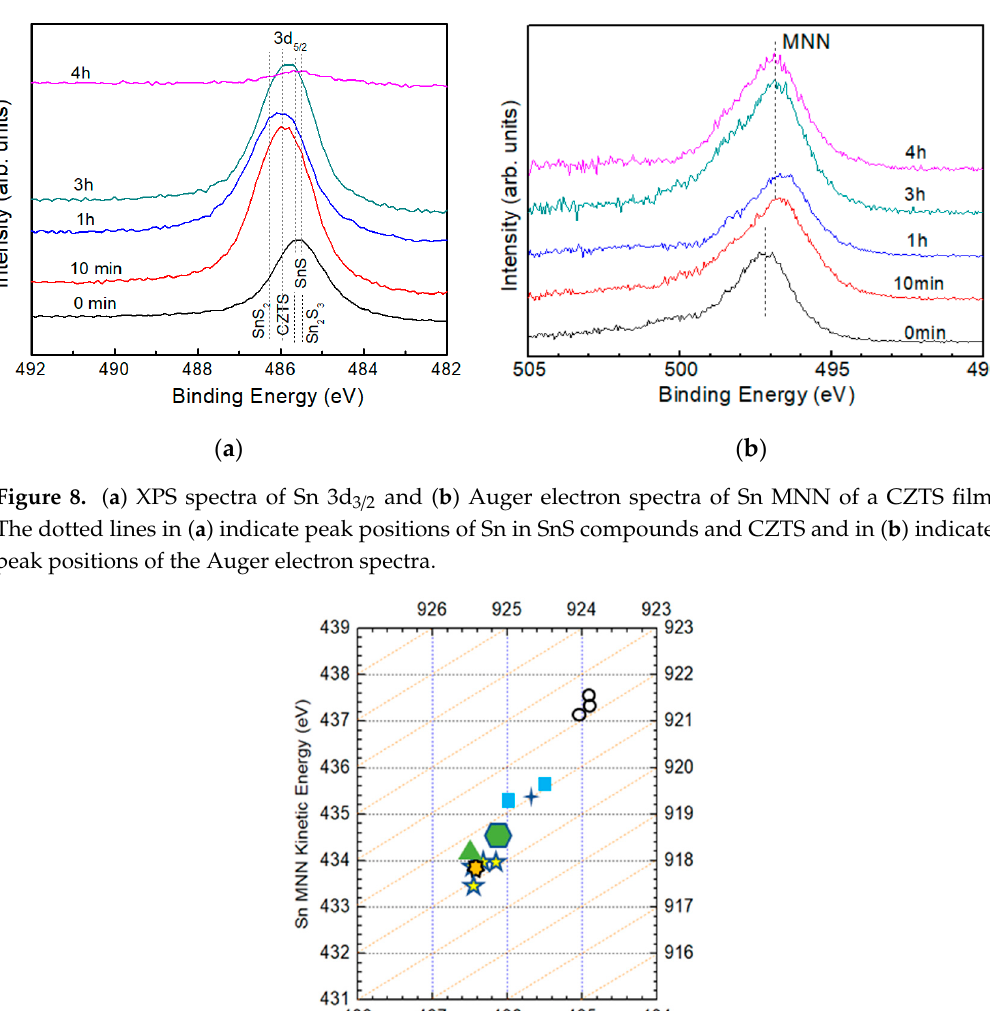
ZnS and SnS compounds.